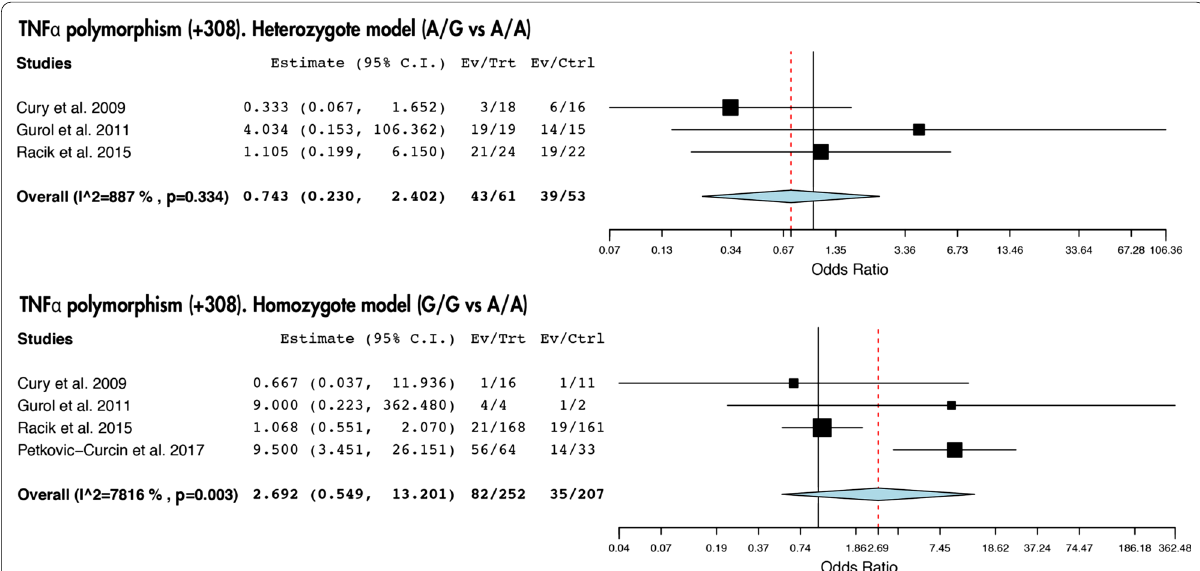
Fig. 3 Association between TNFα ( 308) polymorphism and peri‑implantitis in the heterozygote and homozygote model −